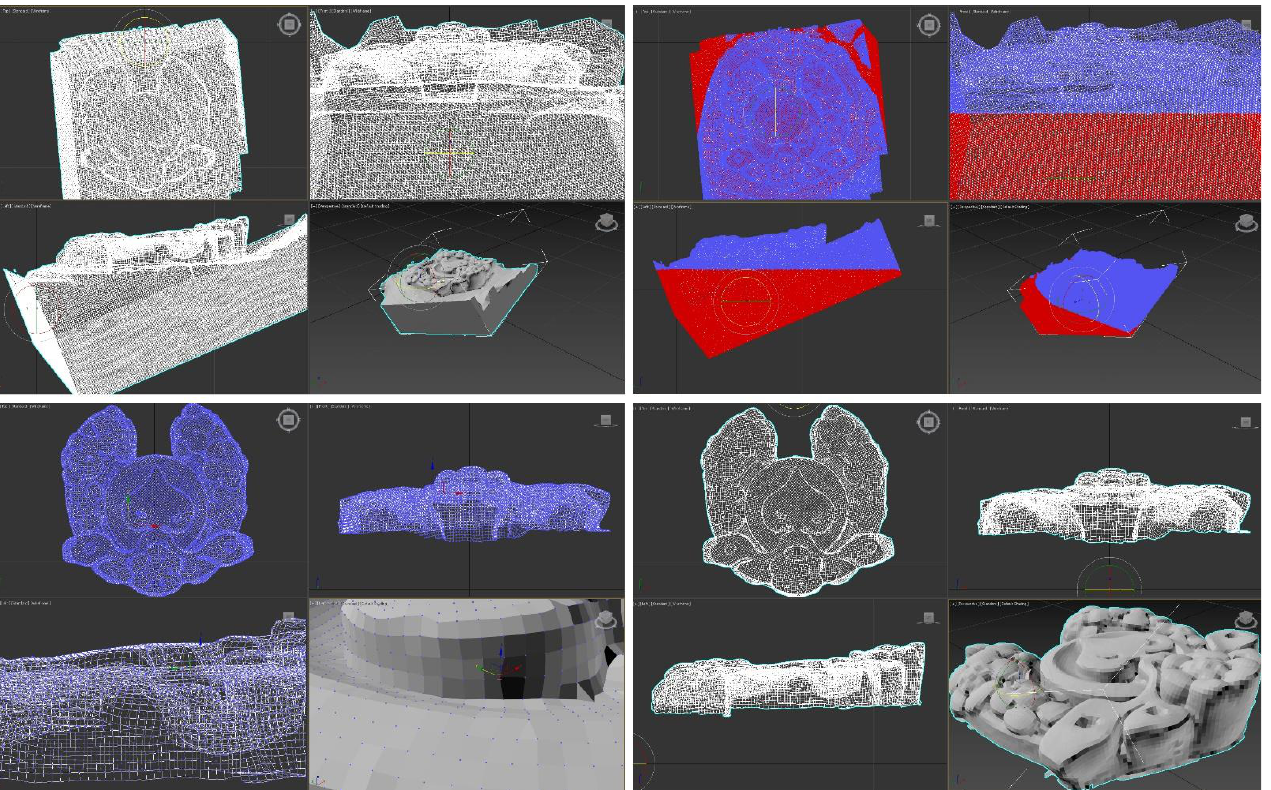
Figure 14. 3D modeling of one of the 3D scanned ornament from the Lajos (Ludwig) Besch and Károly (Karl) Piffl Palace, eliminating the support and background details that are not needed.